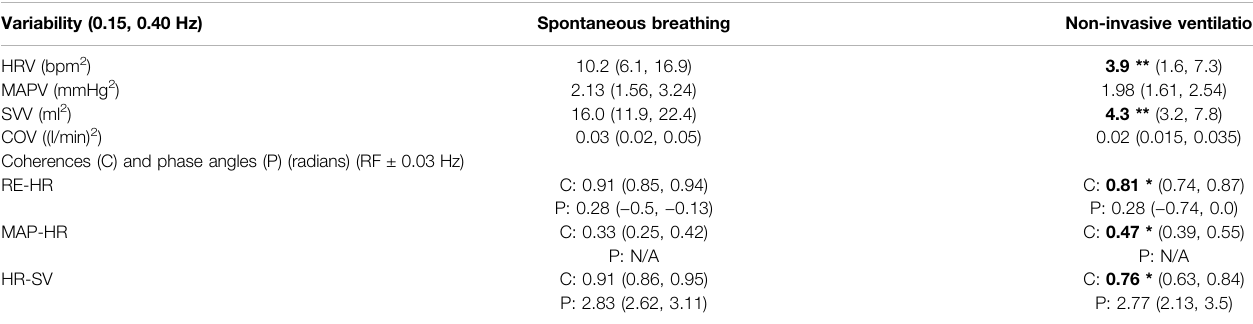
TABLE 2 | Cardiovascular variability at high-frequency interval and coherences and phases at respiratory frequency. Variability (0.15, 0.40 Hz)